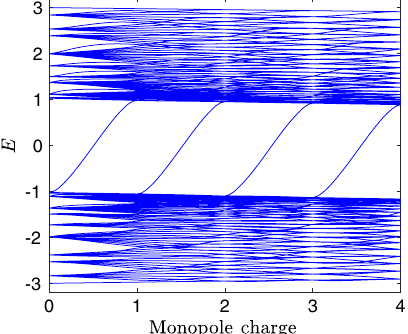
FIG. 8. (a) An N ¼ 3 example of the expanded honeycomb lattice tori used in our calculation. (b) The ð x 0 ; y 0 Þ coordinates on the expanded torus.